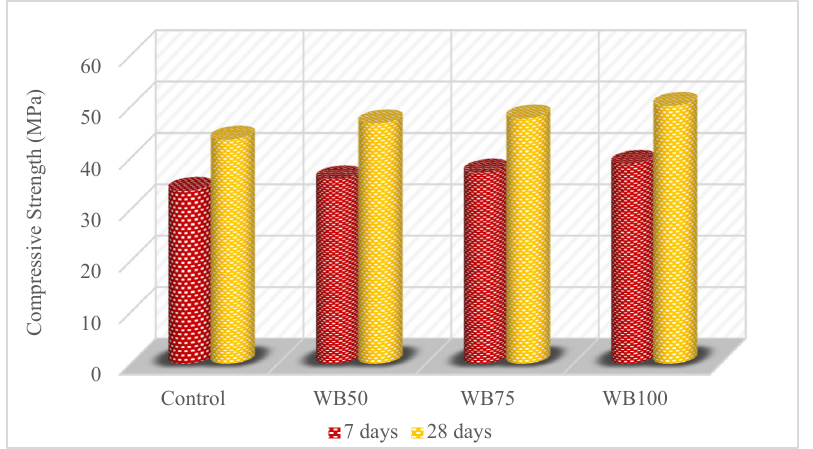
Figure 4. Compressive strength of mixtures.